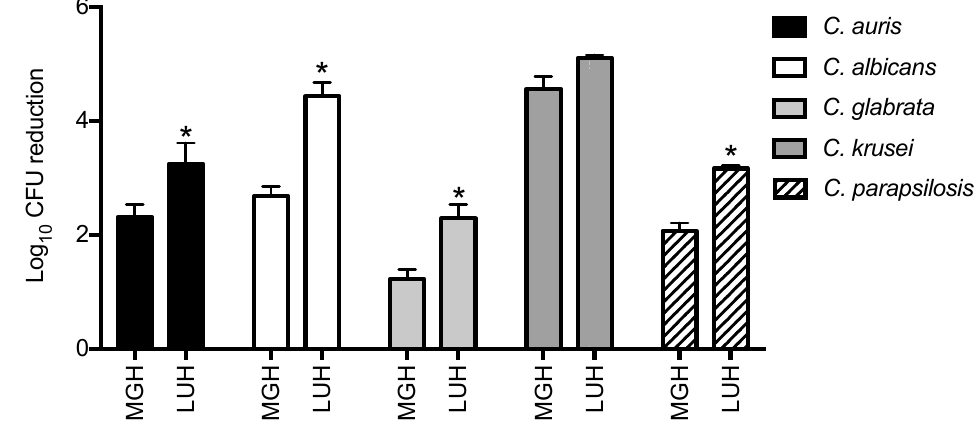
Figure 2. The effect of medical-grade honey vs local honey on the growth of different Candida species. Isolates from five Candida species ( n = 3 for each species) were incubated with 40% of medical-grade honey (MGH) or local unprocessed honey (LUH). Data are presented as reduction in CFU. Significant differences ( p < 0.05) as compared to MGH are indicated with an asterisk.